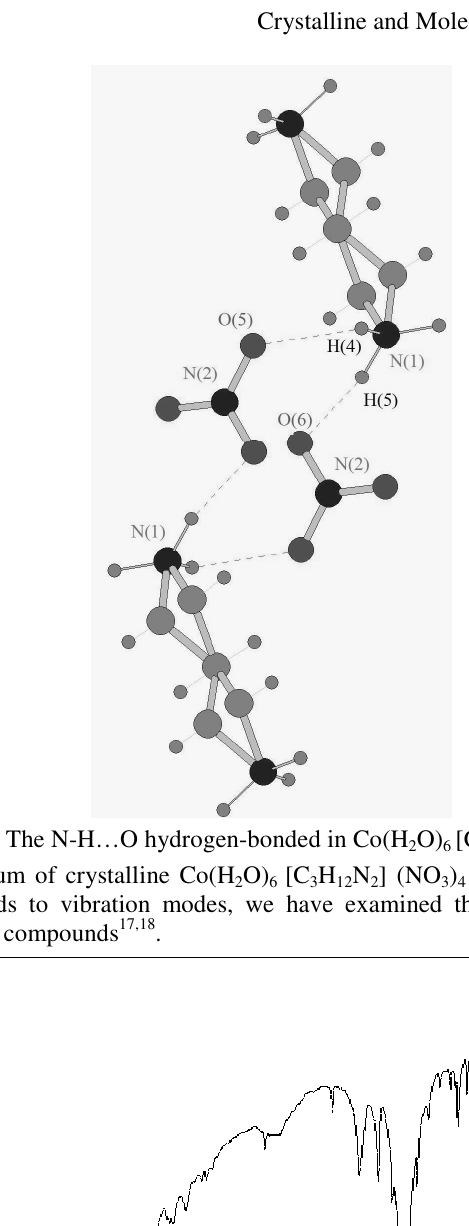
Figure 5. IR absorption spectrum of Co(H